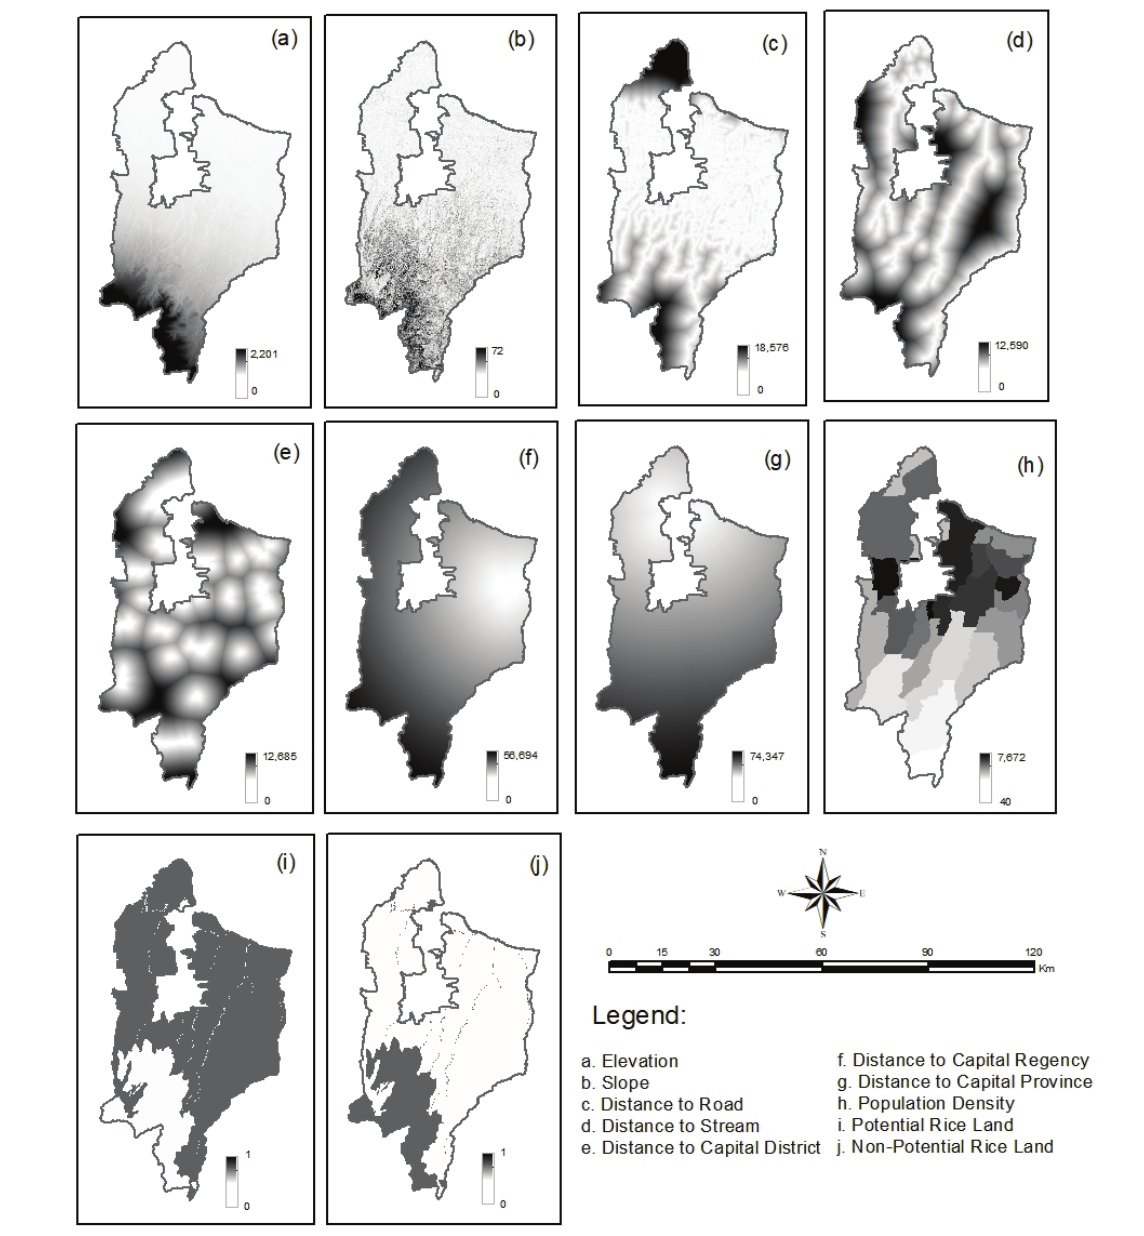
Figure 2. Input factors in